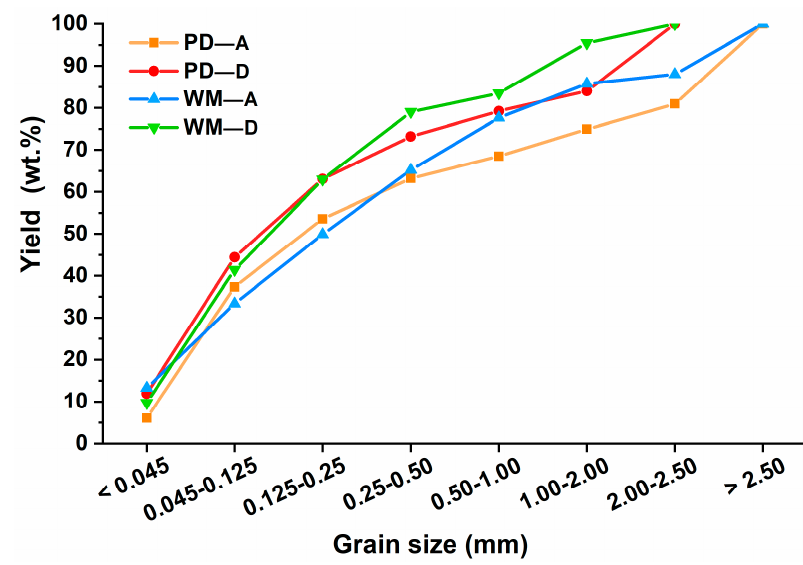
Figure 6. The grain size analysis of ash (A) and deposits (D), PB-A, PB-D and WM-A, WM-D.